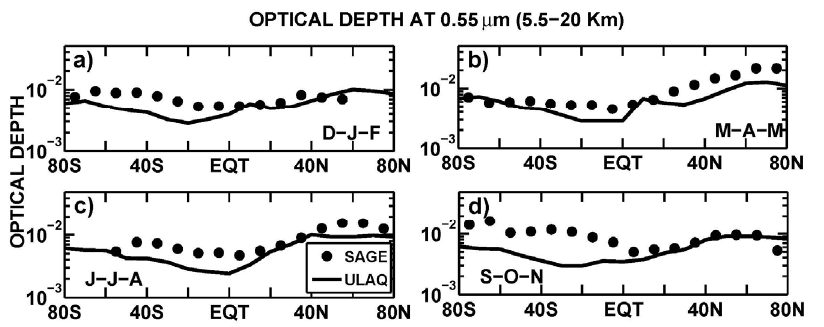
Figure 3. Annual cycle of aerosol optical depth at λ =0.55 μ m over United States (left panel ( a )), North Atlantic (mid panel ( b )) and Europe (right panel ( c )). AVHRR, MODIS and TOMS satellite retrievals are used for comparison with the ULAQ model calculations.